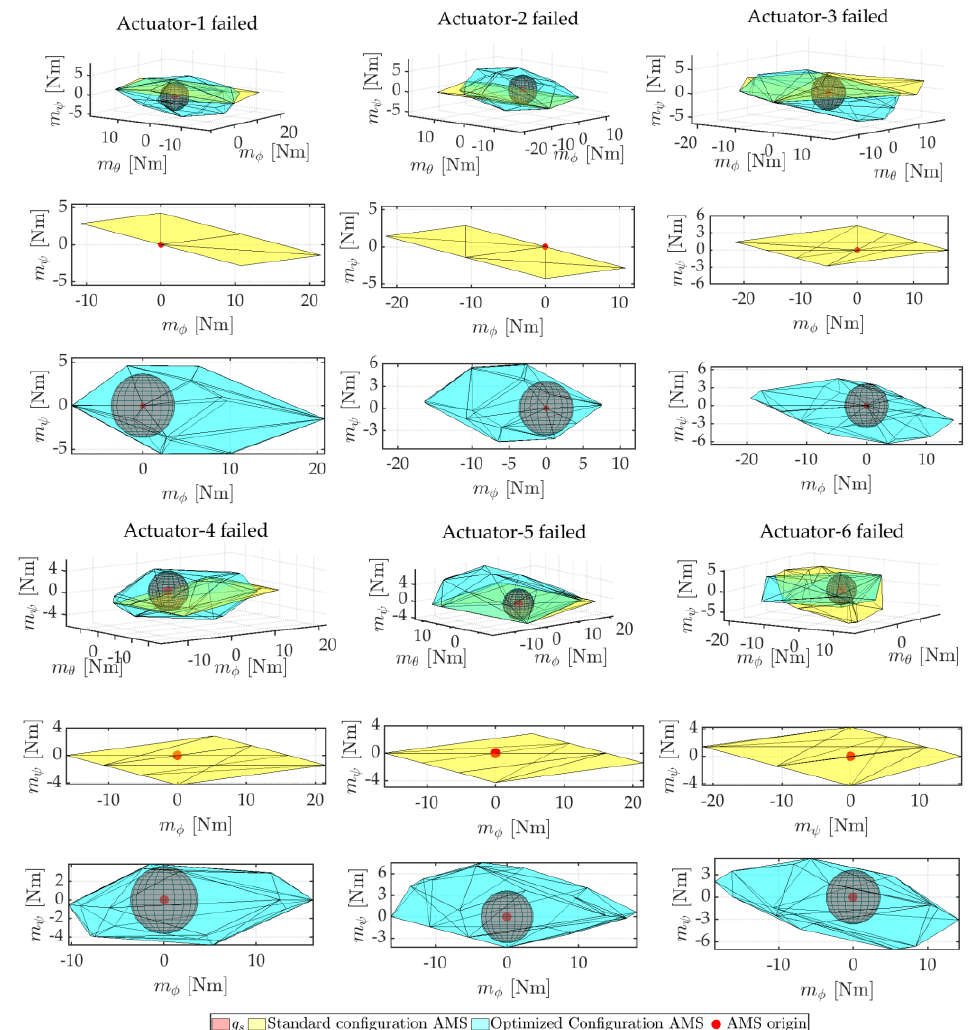
Figure 10. AMS comparison of preliminary configuration with optimized configuration for each actuator failure.